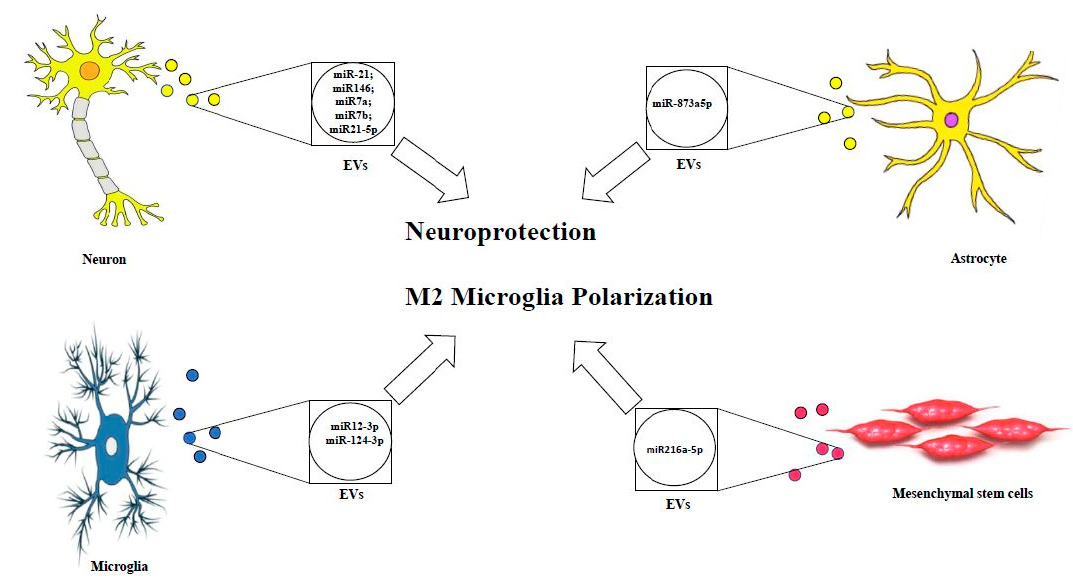
Figure 1. Therapeutic effects of EVs cargo in TBI.